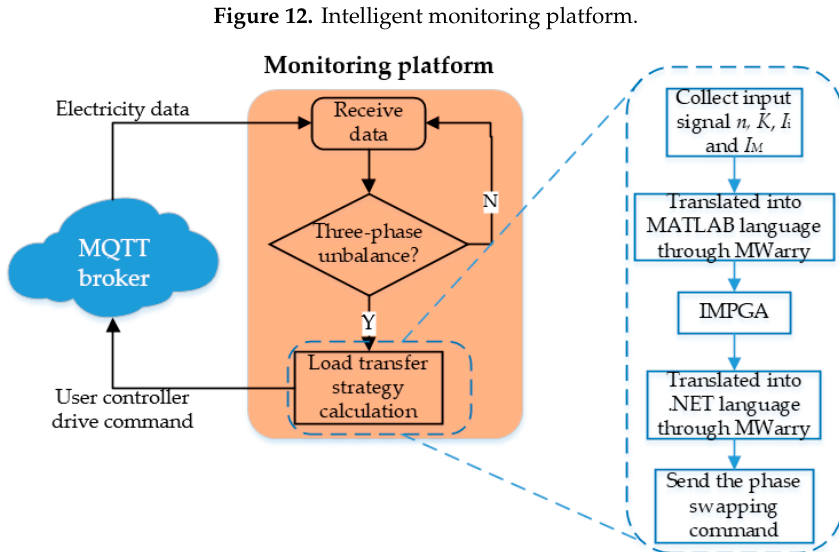
Figure 12. Intelligent monitoring platform.